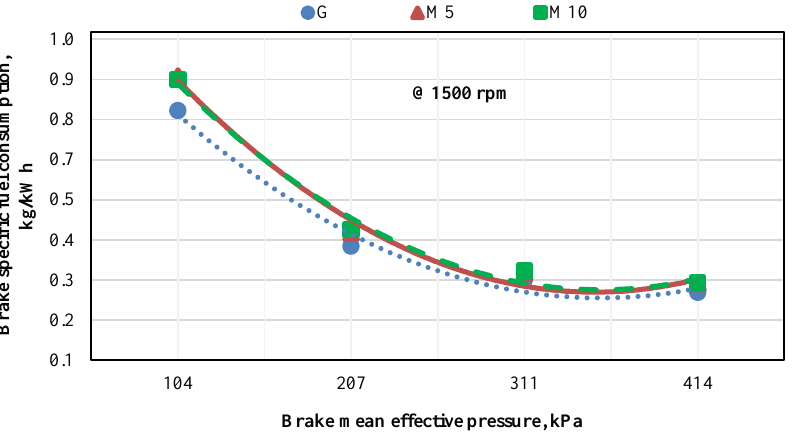
Fig. 3. Brake specific fuel consumption of the engine for tested fuels at different loads.